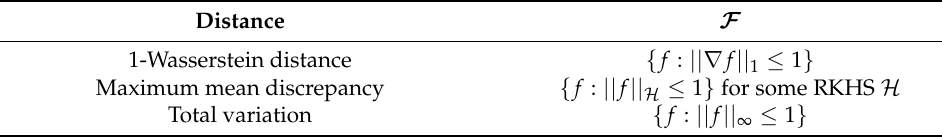
Table 2. Some examples of integral probability metrics.